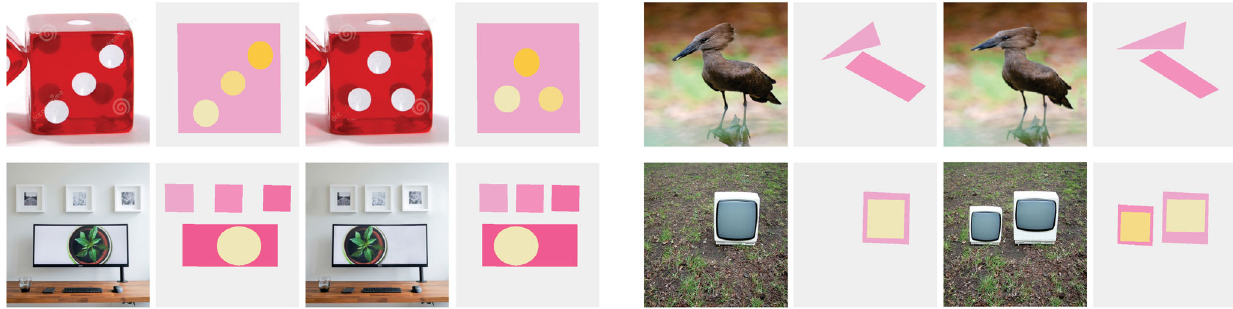
Fig. 8 High-level image editing of real world images based on detected primitives. The first two columns of each group show the original image and its layered decomposition while the last two columns of each group show manipulated